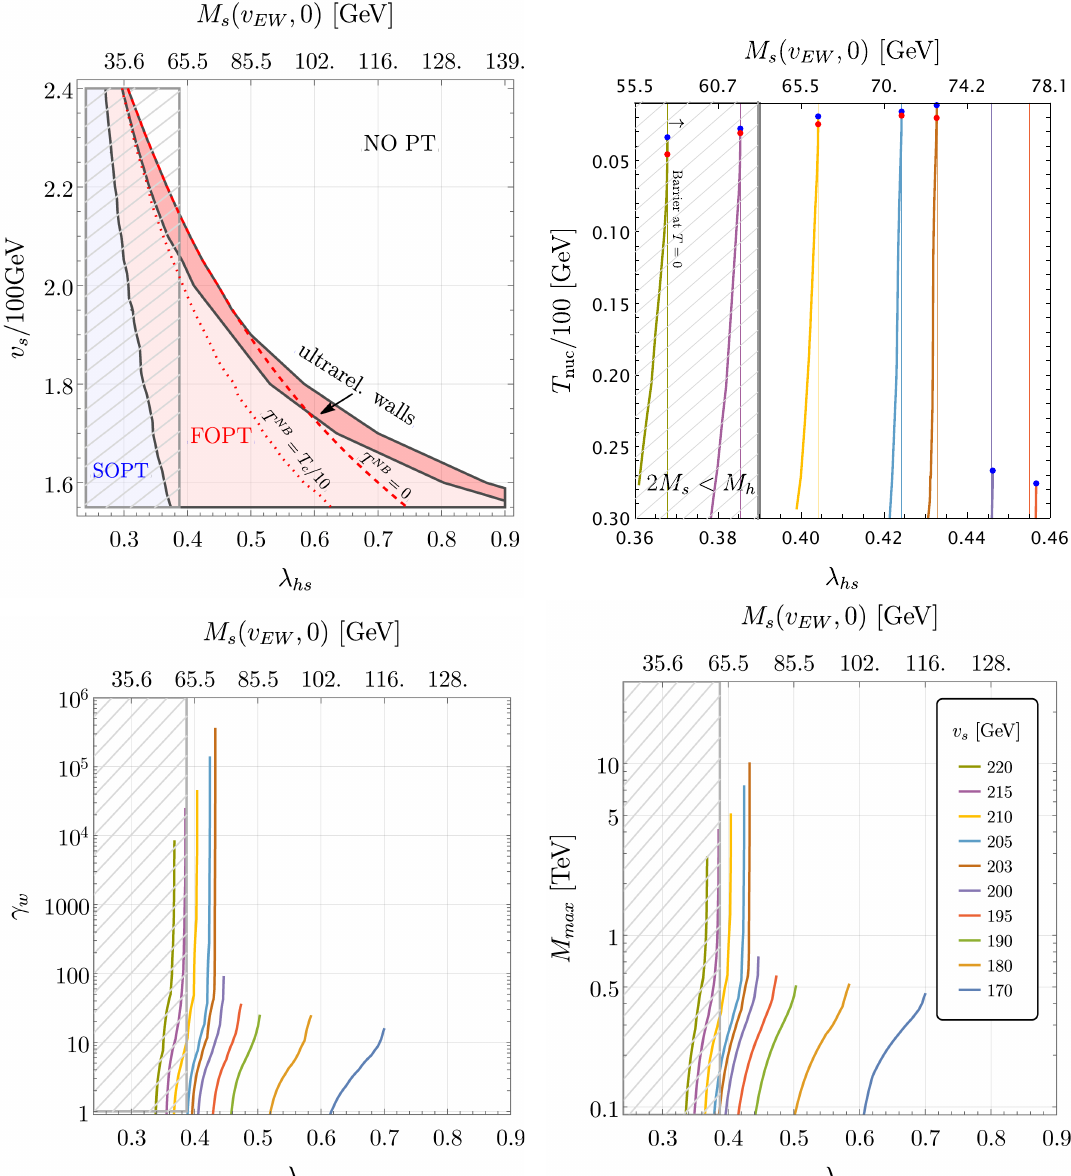
Figure 1 . Top-Left : scan of the parameter space in the plane λ hs − v s for m s = 125 GeV. The four regions are as follows: i) white - NO PT, the region where the transition never completes because the barrier remains at zero temperature and the function S 3 /T never passes below the nucleation condition, ii) light and dark red are the regions where the FOPT happens. Dark (light) red corresponds to the region with relativistic (non-relativistic) bubble expansion. The boundary between two regions is given by eq. (3.14) iv) blue - the phase transition is of the second order. The gray meshed region is the one in which M s ( v EW , 0) < m h / 2 , that is constrained from collider experiments. Top-Right and Bottom : the dependencies of T nuc , γ w , M max on the λ hs coupling for m s = 125 GeV. The blue dot on the Top-Right plot designates the end of the curve, when the tuning becomes 10 − 6 and the red dot signals the appearance of a barrier at zero temperature (all the points above the red dot have a barrier at T = 0 ). For the last three plots we varied the λ hs parameter with the steps of 10 − 6 . The value of v s is encoded in color according to the bottom-right